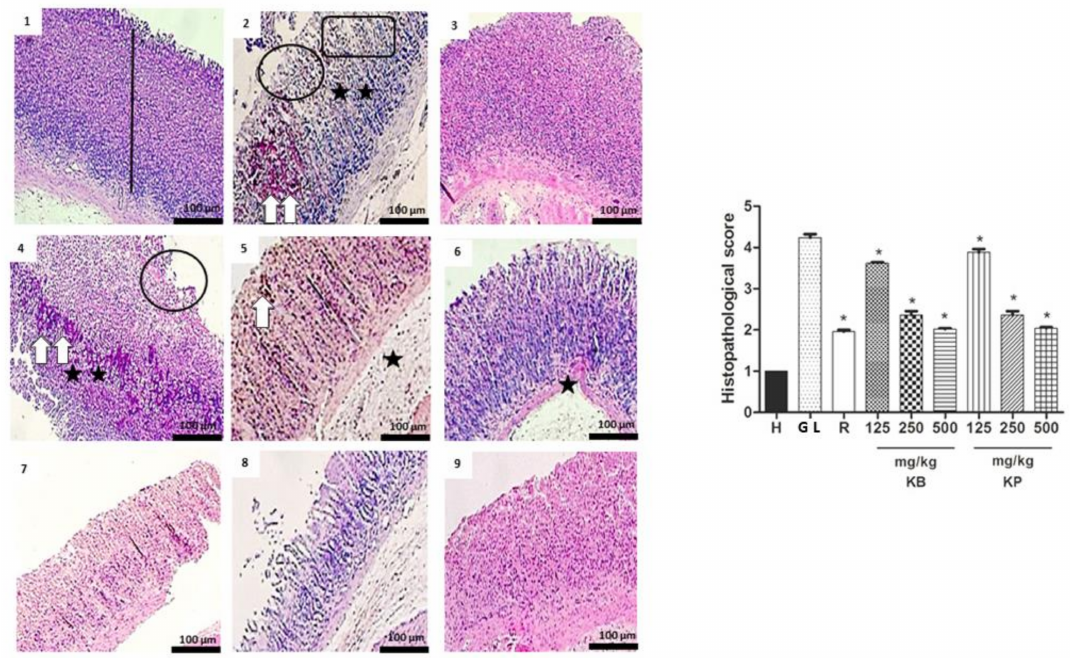
Figure 6. Effect of pre-treatment with K. brasiliensis and K. pinnata leaf juice (125, 250 and 500 mg/kg) on the histology of ethanol-induced gastric mucosal damage in rats. Histopathological characteristics of the gastric tissue of rats, showing the cut of the stomach in the longitudinal direction. (1) Healthy; (2) Gastric lesion control; (3) Ranitidine; (4) K. brasiliensis 125 mg/kg; (5) K. brasiliensis 250 mg/kg; (6) K. brasiliensis 500 mg/kg; (7) K. pinnata 125 mg/kg; (8) K. pinnata 250 mg/kg; (9) K. pinnata 500 mg/kg. The bar indicates gastric mucosa without changes; Circle and rectangle: necrotic lesions and severe distraction of the surface epithelium, respectively; Two white arrow: intense hemorrhage; One white arrow: small hemorrhage points; Two asterisks: intense inflammatory infiltrate; One asterisk: weak inflammatory infiltrate. Data expressed as mean ± standard mean error, ( n = 5). Mann–Whitney used to calculate statistical significance, * p < 0.05 vs. gastric lesion control. Healthy, H; Gastric lesion control, GL; Ranitidine, R. K. brasiliensis , KB; K. pinnata ,